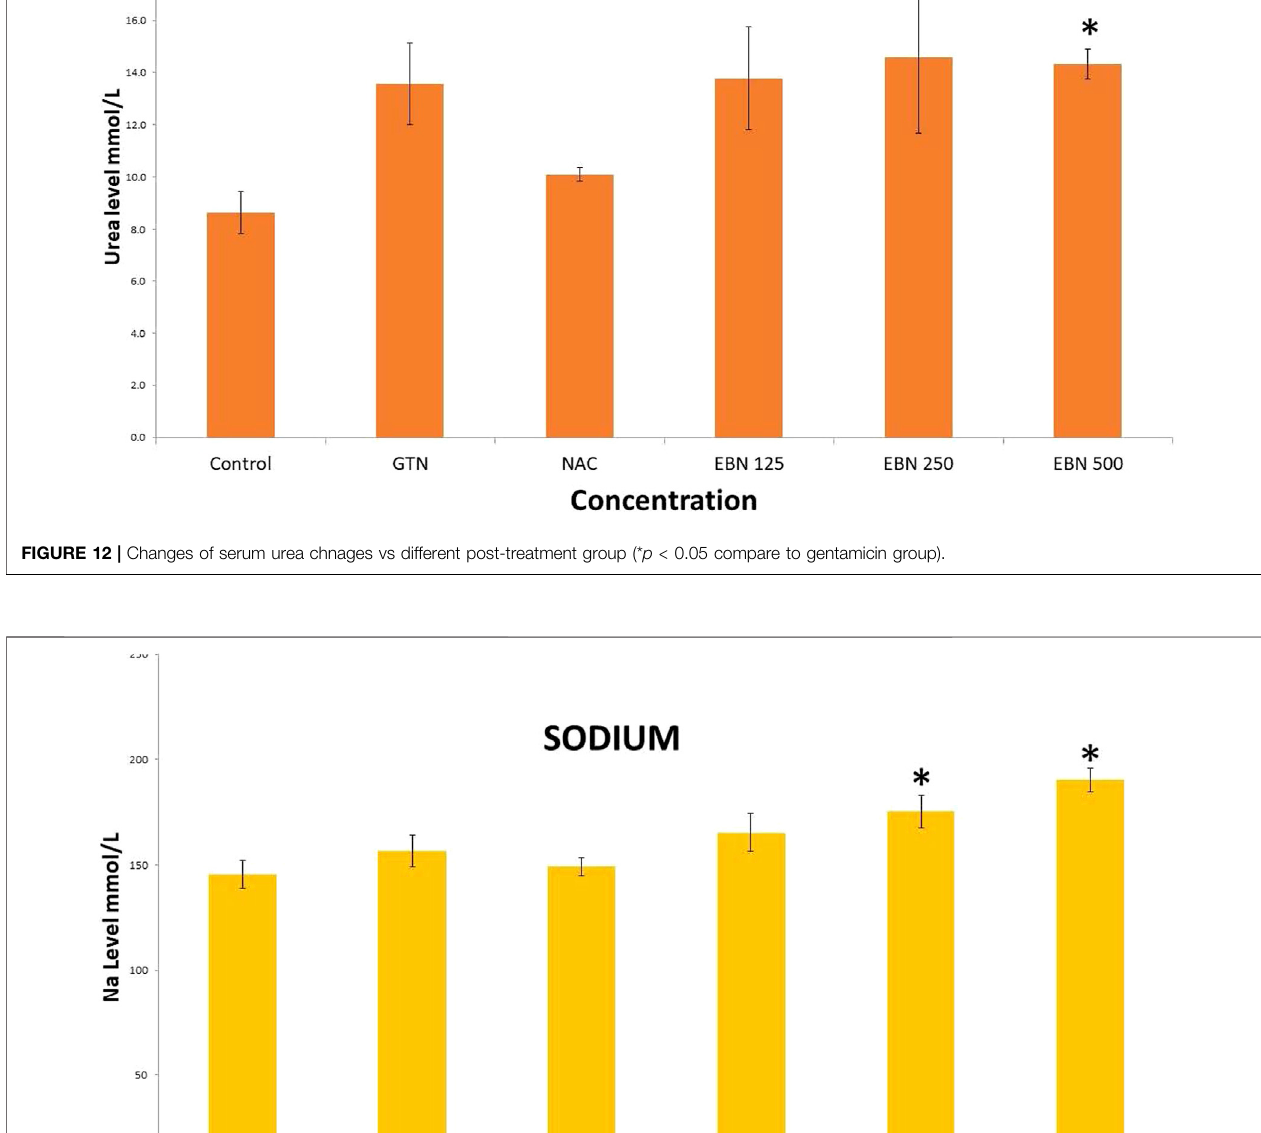
Frontiers in Pharmacology |